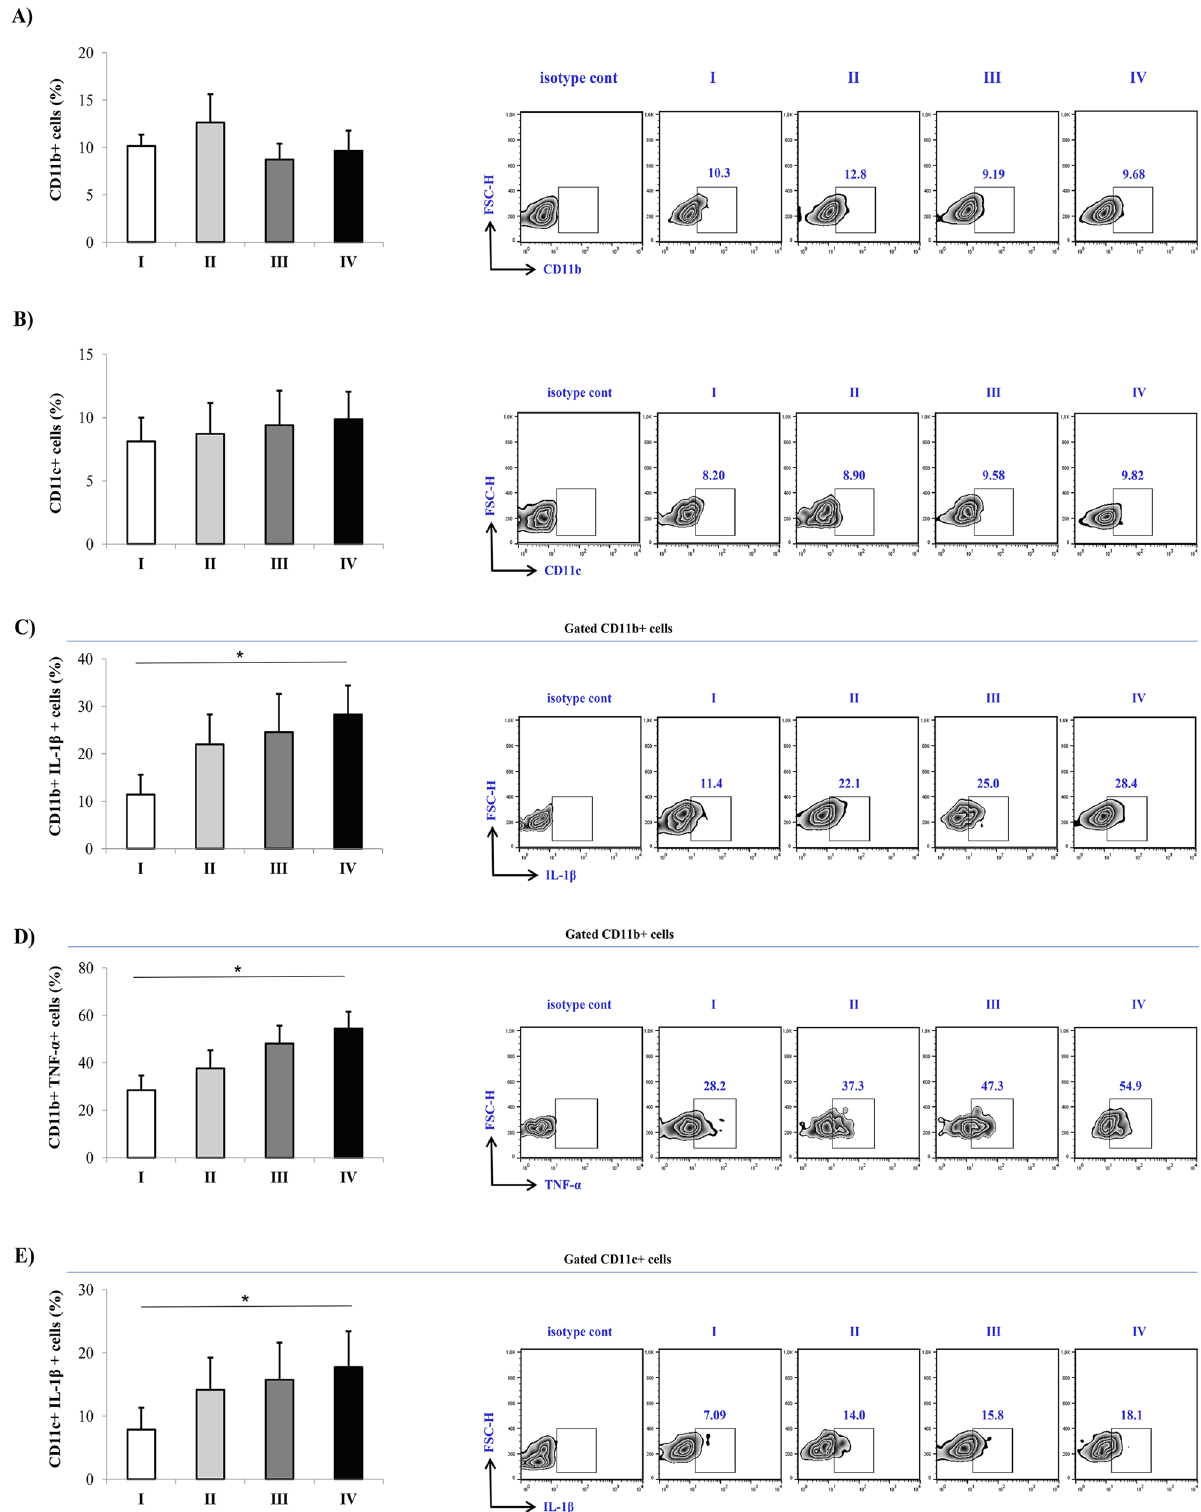
Figure 3. Increment in percentage of TNF-α + , and IL-1β + dendritic cells and monocytes in stage IV patients with COVID-19. The graph and representative FACS plots displaying the percentage of CD11b + , CD11b + IL-1β + , CD11b + TNF-α + cells, CD11c + , CD11c + TNF-α + cells, among PBMCs of patients in all progressive stages of COVID-19 [stage I (n = 19), II (n = 21), III (n = 22), IV (n = 24)]. Isotype control for each measured marker is also displayed. The Kruskal–Walli’s test (with post-hoc Mann–Whitney U -test) was applied to evaluate statistically significant differences. *p <